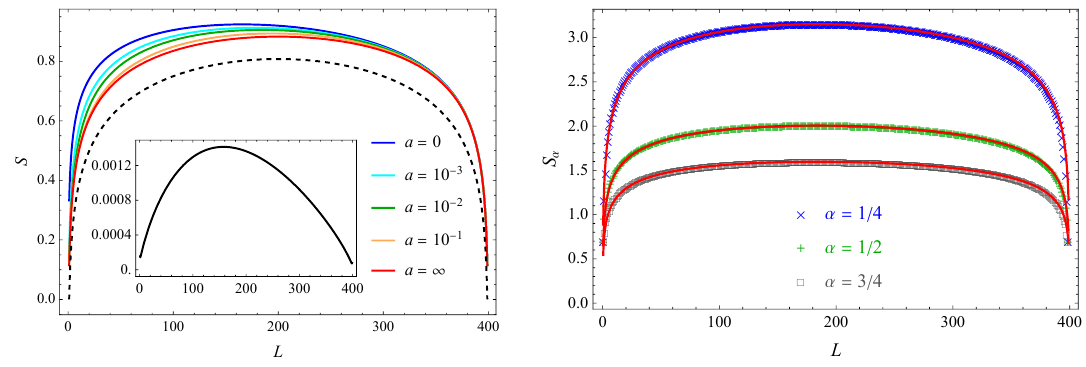
Figure 1 . Left: leading term in the asymptotic approximation (4.14) to the von Neumann en- tanglement entropy of the sextic chain with N = 400 spins for a = 0 , 10 − 3 , 10 − 2 , 10 − 1 , ∞ (the dashed black line represents the analogous quantity for the homogeneous XX chain). Inset: relative error between the a = 1 and a = ∞ approximations. Right: Rényi entanglement entropy of the sextic chain with N = 400 spins and a = 10 − 2 for α = 1 / 4 , 1 / 2 , 3 / 4 , compared to its asymptotic approximation (4.14) (solid red